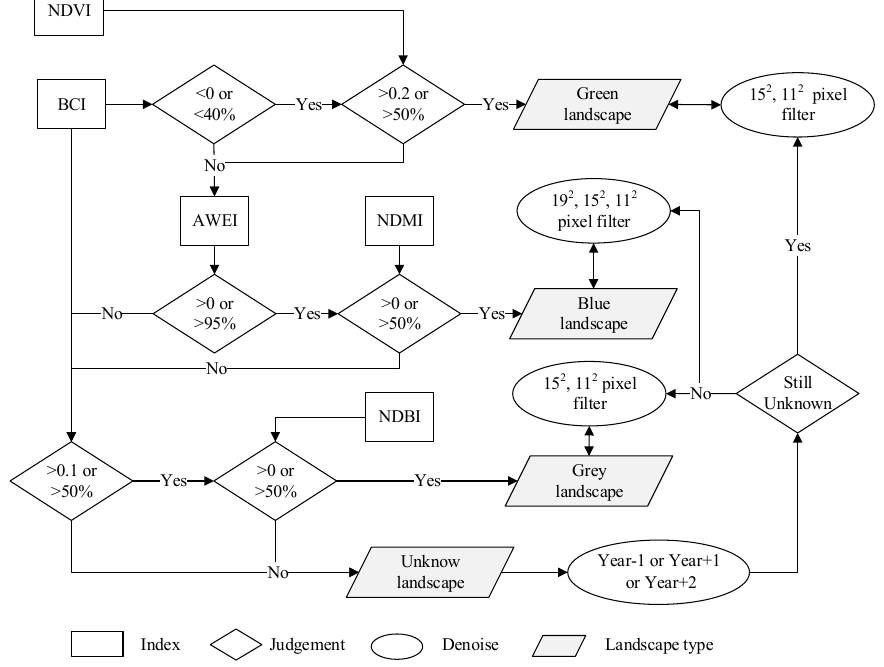
Figure 2. Technical flow chart for the decision tree classification.